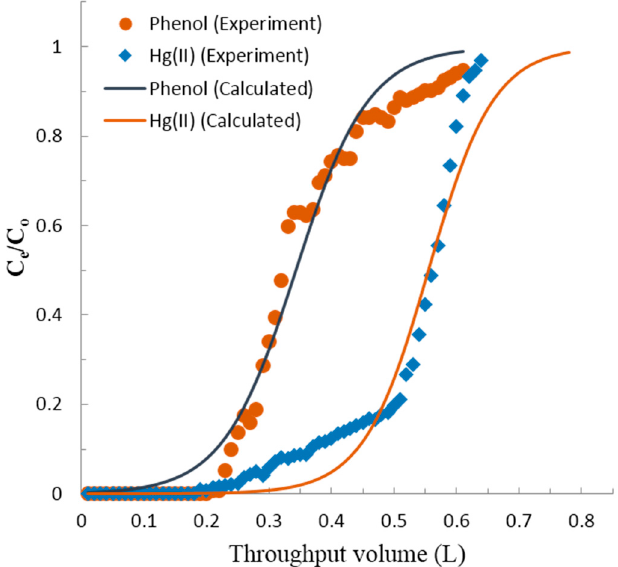
Figure 10. Breakthrough curve of Hg(II) and phenol (pH: 5.0; Initial (Hg(II)) concentration: 4.5 mg/L, Initial (phenol) concentration: 7.89 mg/L; Flow rate: 0.5 mL/min).